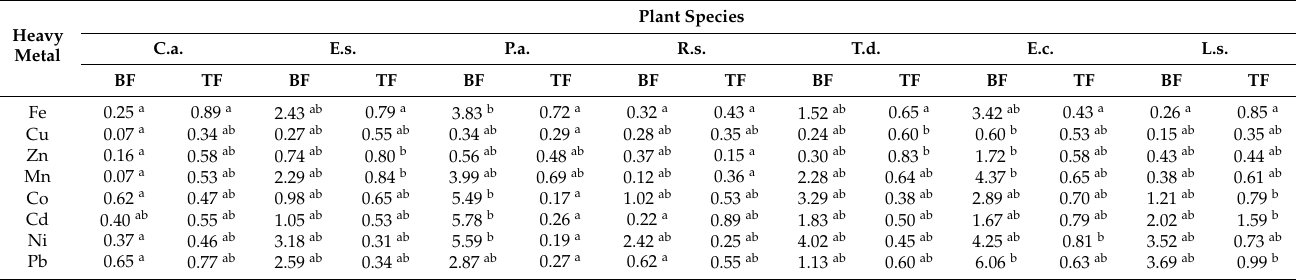
Table 3. Bioaccumulation factor (BF) and translocation factor (TF) of heavy metals in the studied species. Highlighted values represent BF and TF mean values greater than